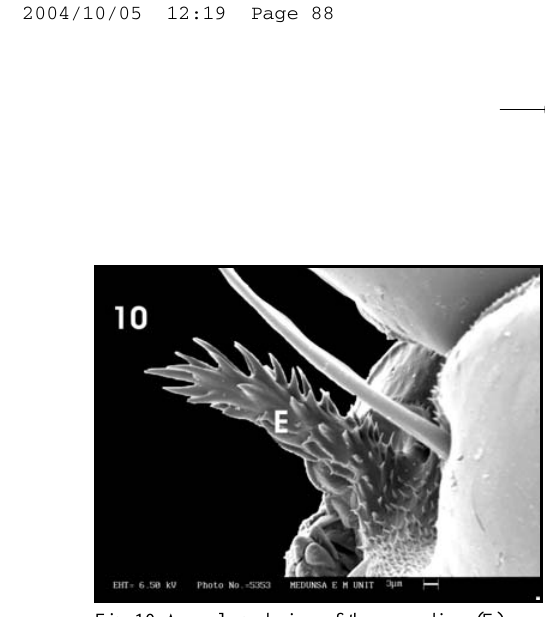
Fig. 10. An enlarged view of the empodium (E)